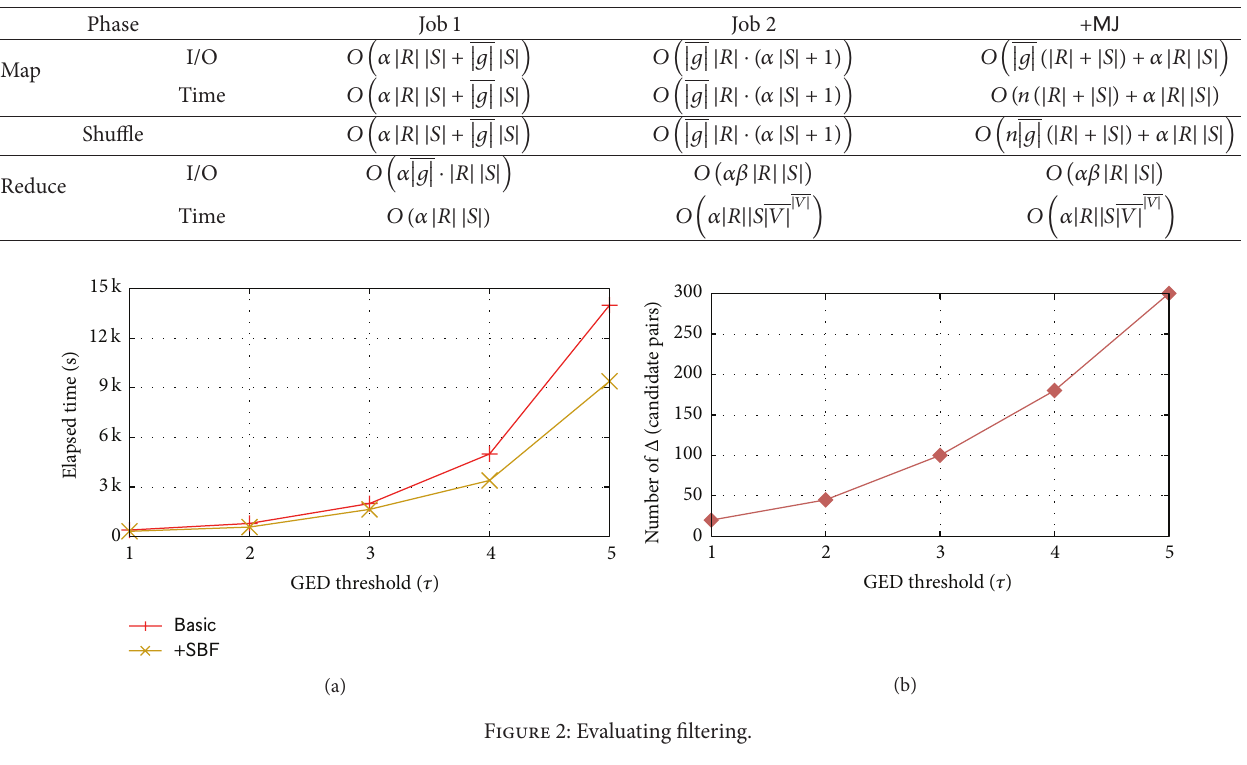
Table 2: Complexity analysis of verification.